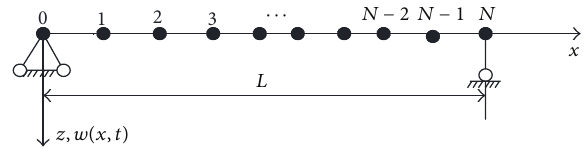
Figure 3: Spline discretization of axially FG tapered beams.